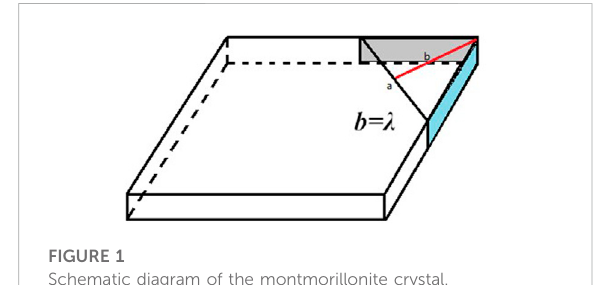
FIGURE 1 Schematic diagram of the montmorillonite